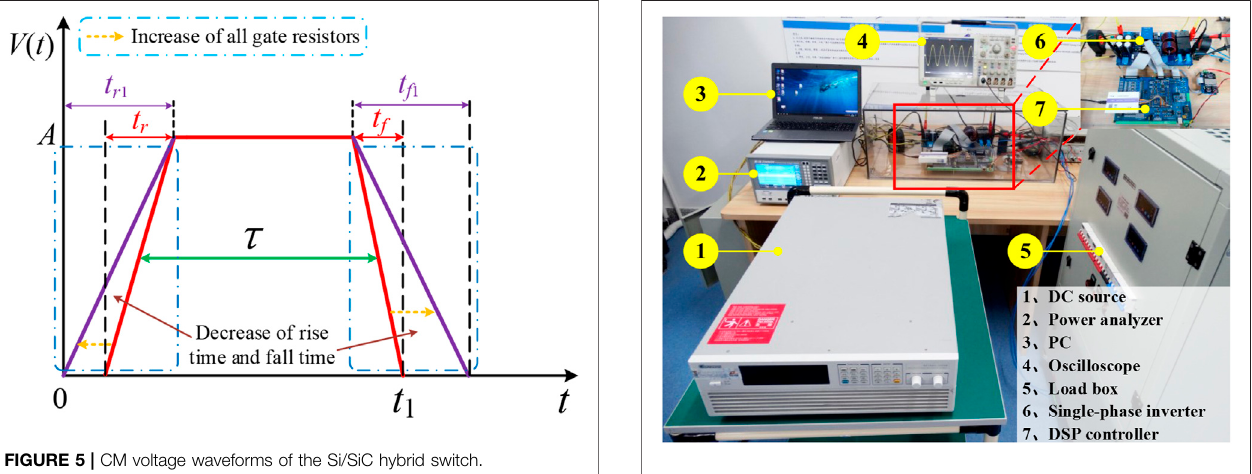
FIGURE 6 | Experimental platform.